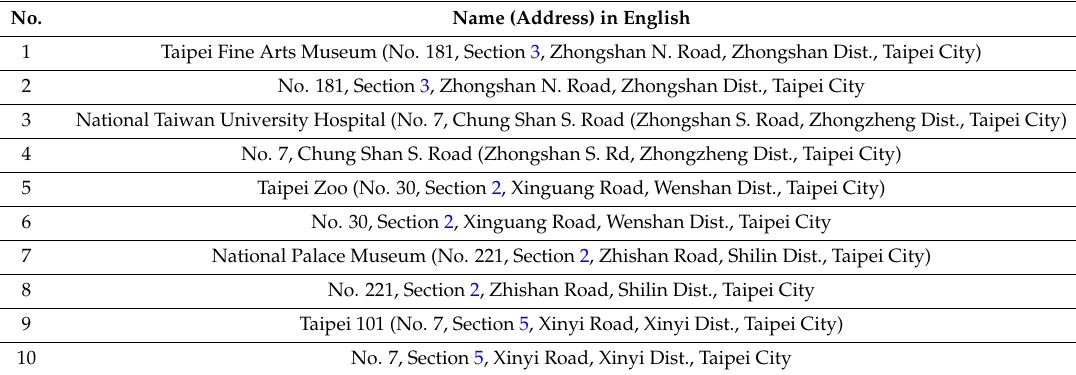
Table 4. Addresses selected from five districts in Taipei